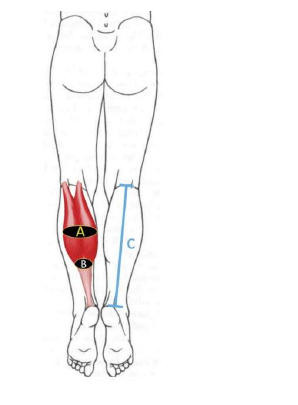
Figure 1. Anthropometric features assessed on the calf: ( A ) Calf girth assessed in the mid-third of the calf; ( B ) Calf girth assessed in the distal -third of the calf; ( C ) Calf length (measured from the popliteal fossa to the calcaneal